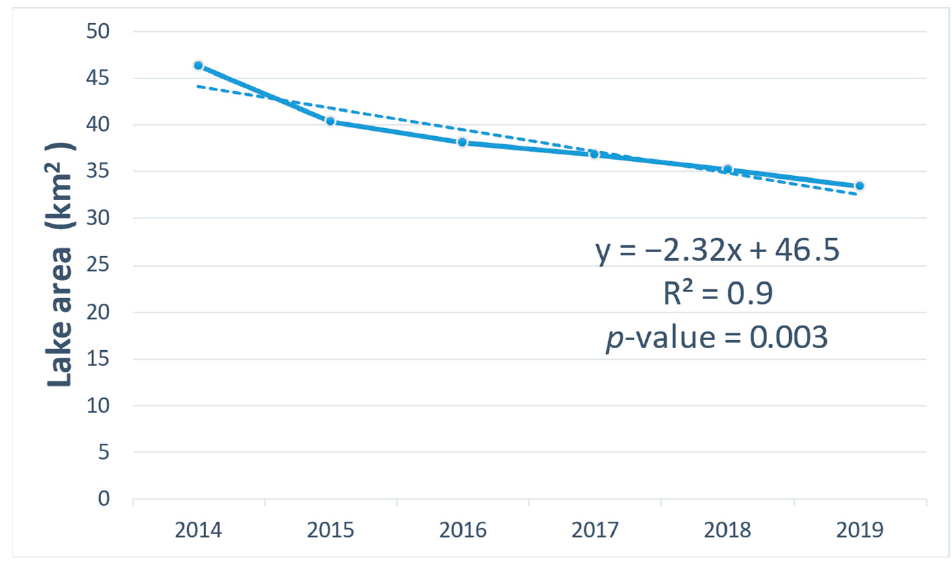
Figure 6. Mean lake area between 2014 and 2019 for four disturbed lakes (D1–D4). ( p -value = 0.0033). The areas of all lakes above the road decreased between 2014 and 2019 (Table